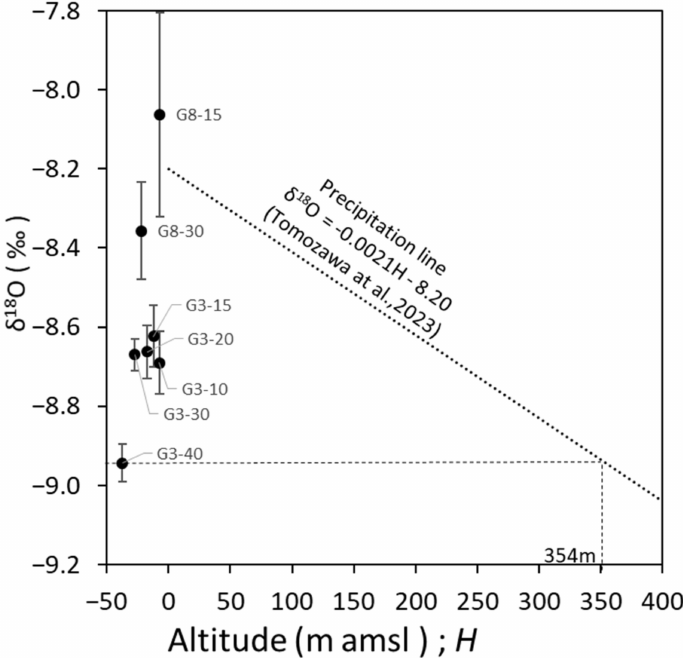
Figure 4. Estimation of the groundwater recharge altitude based on δ 18 O. (Tomozawa at al., 2023